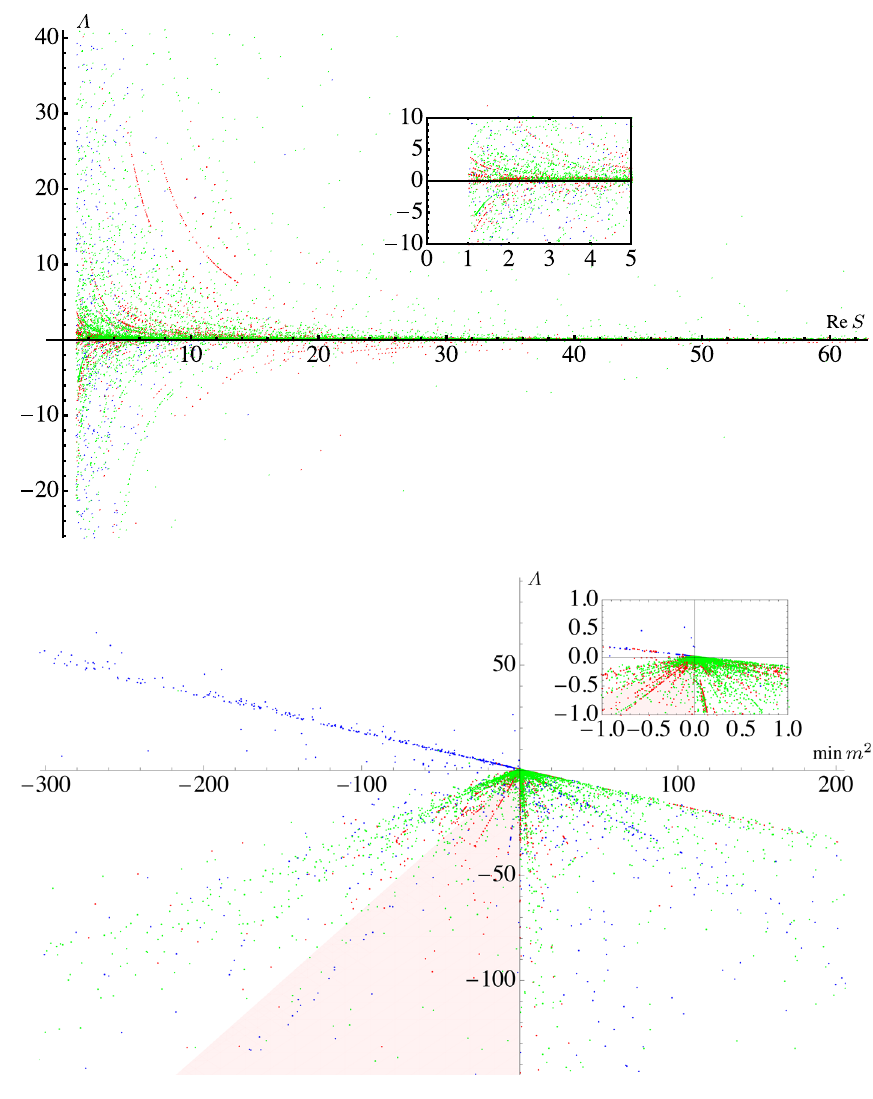
Fig. 8 Distribution diagram of the values of the extrema for the scalar potential RdSC. Red and blue points represent critical points obtained through the classification of randomly selected flux configurations (Case A) whereas green and yellow points correspond to critical points obtained by assuming hierarchical fluxes (Case